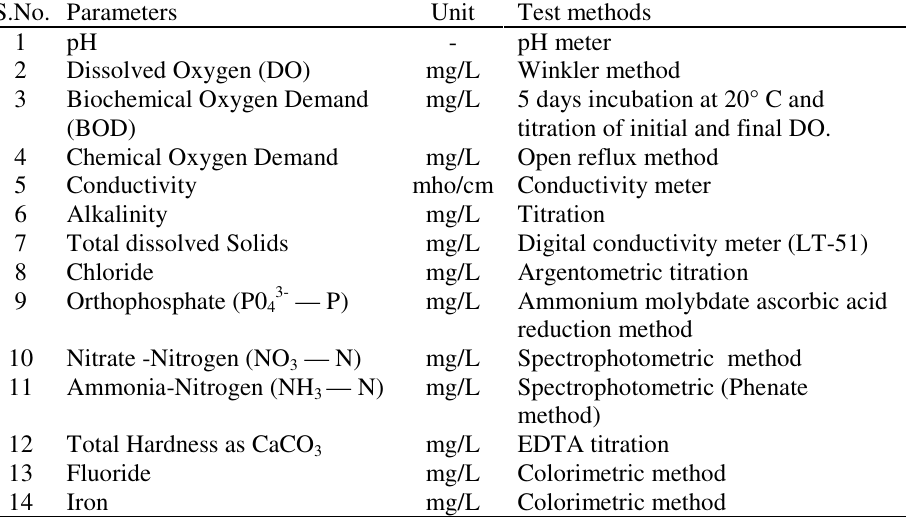
Table 1. List of Chemical parameters and their test methods S.No.